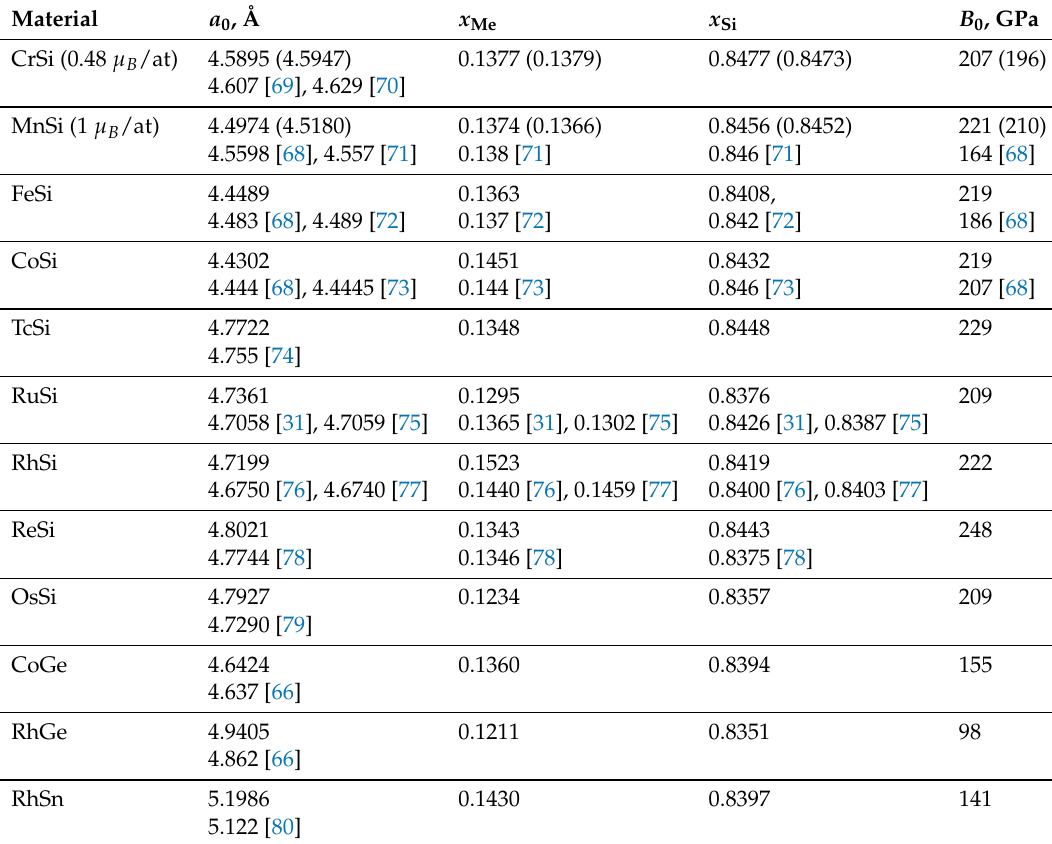
Table 2. Lattice parameters and bulk moduli for B20 monosilicides of different transition metals, obtained by fitting to the Birch–Murnagan equation of state, including atomic-force relaxation for zero magnetic moment and allowing for nonzero magnetic moment (in parentheses). Experimental values were taken for comparison from Refs.